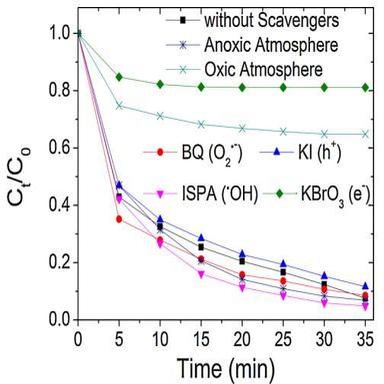
Effects of oxic and anoxic conditions as well as of different scavengers on the reduction efficiency (in terms of NP concentration at time t normalized to the initial concentration at t = 0) by TCF nanocomposite under UV light irradiation.